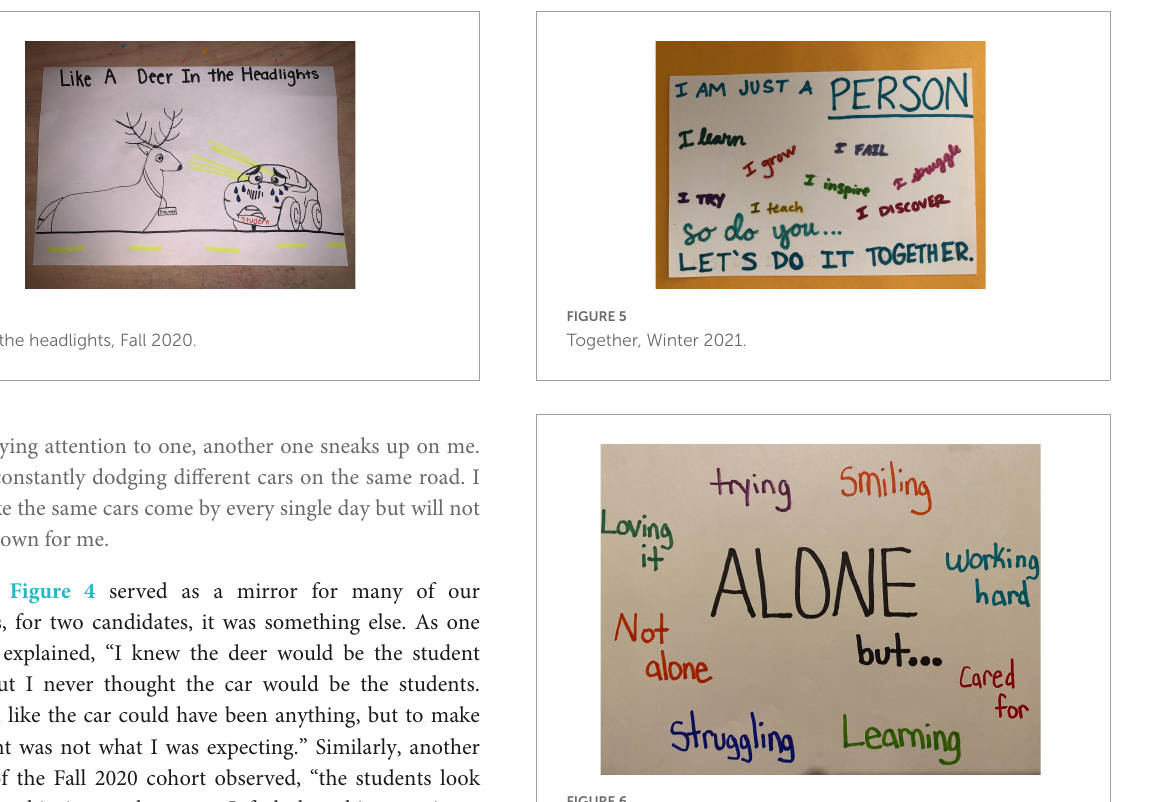
FIGURE6 Alone but, Fall